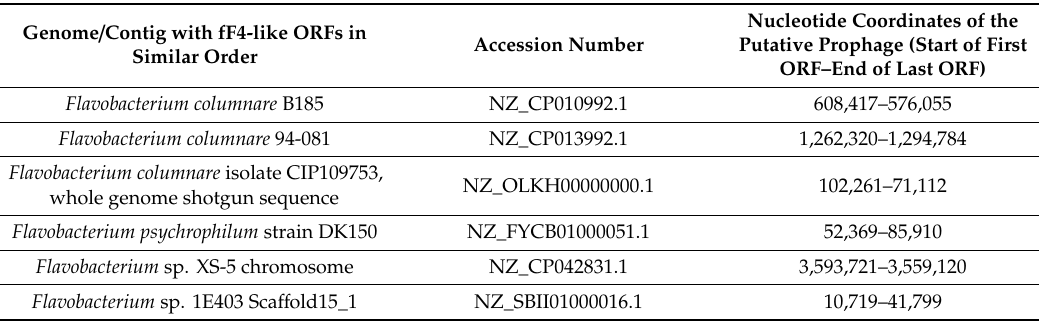
Table 1. The presence of fF4-like prophage in bacterial strains and species based on partial amino acid similarities combined with genome synteny (see also Table